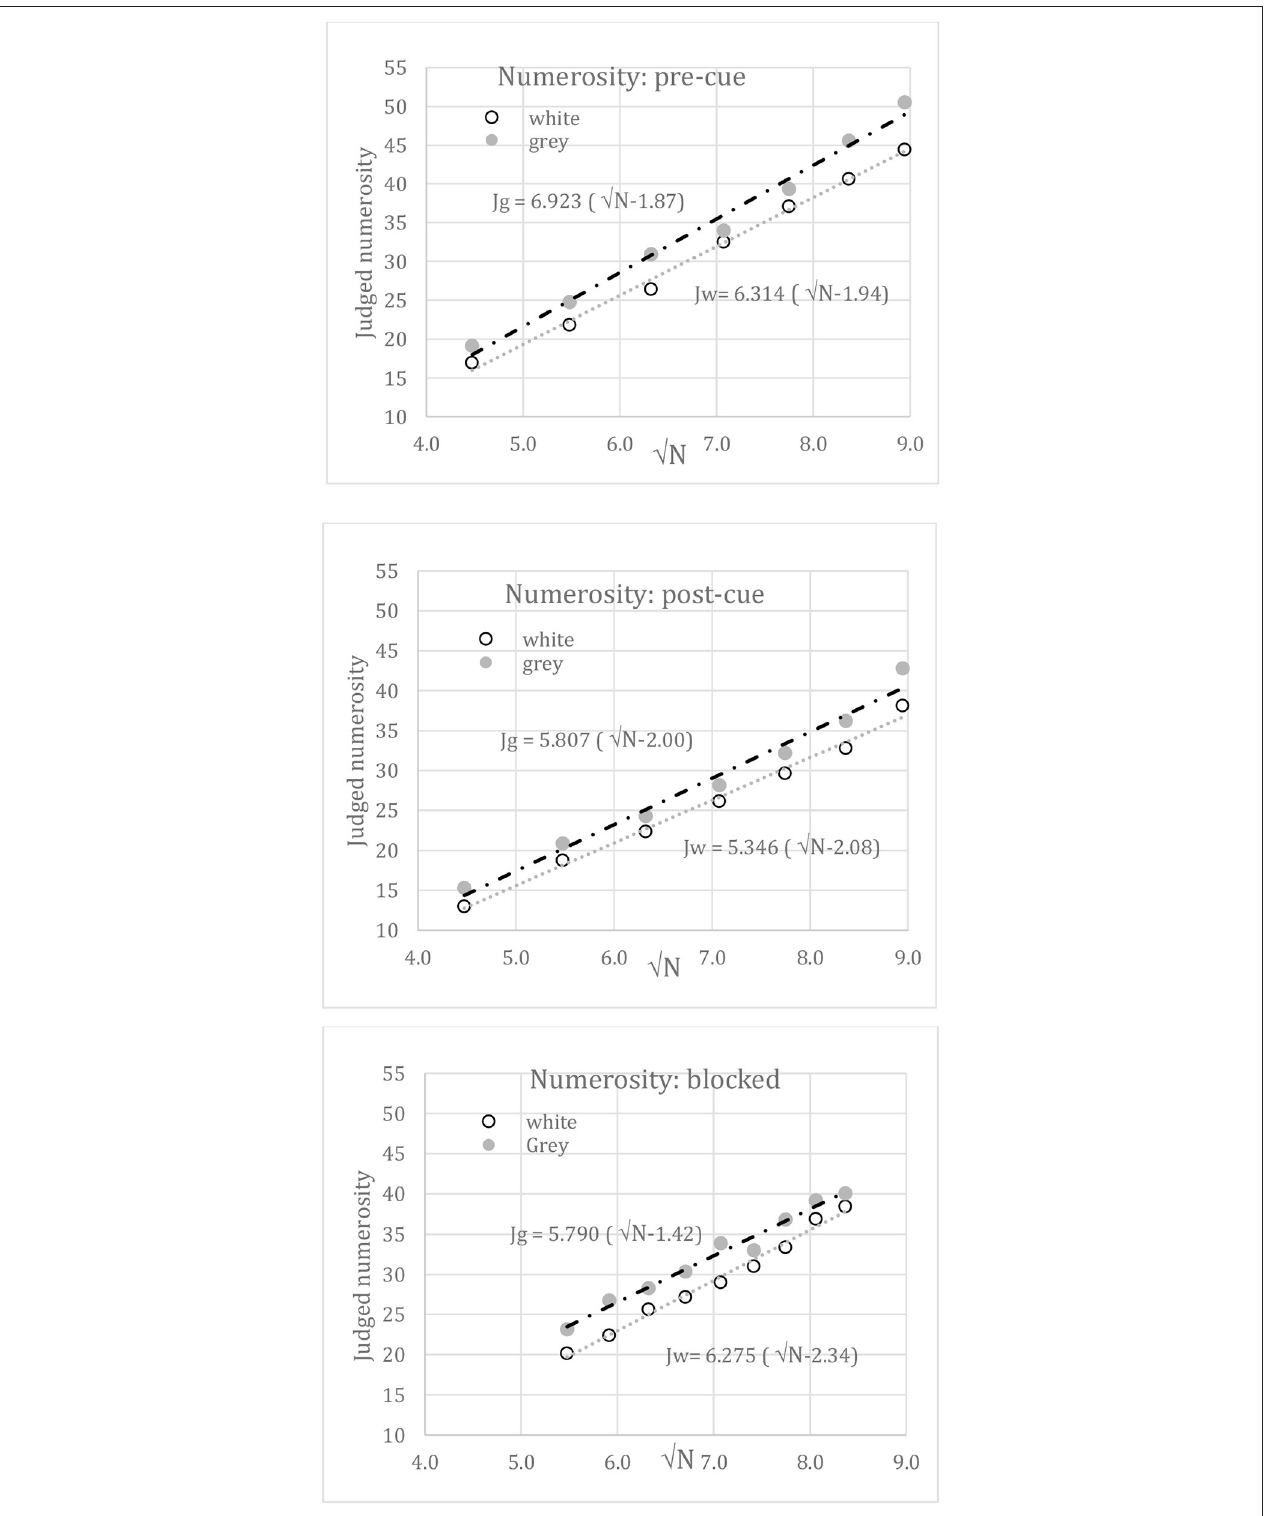
FIGURE 7 | Mean judged numerosity vs. √ N when disk sets were intermingled. Top: the set to be judged was randomized and pre-cued on each trial. Middle: the set to be judged was randomized and post-cued. Bottom: the set to be judged was blocked. Lines show linear best-fits to √ N. These fits are empirical.